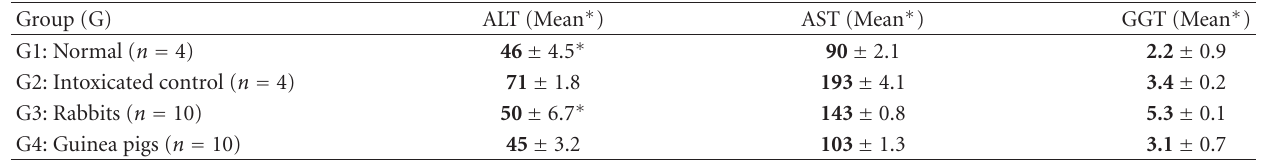
Table 2: Biochemical analysis for acute toxicity of the Hibiscus aethiopicus L. plant.